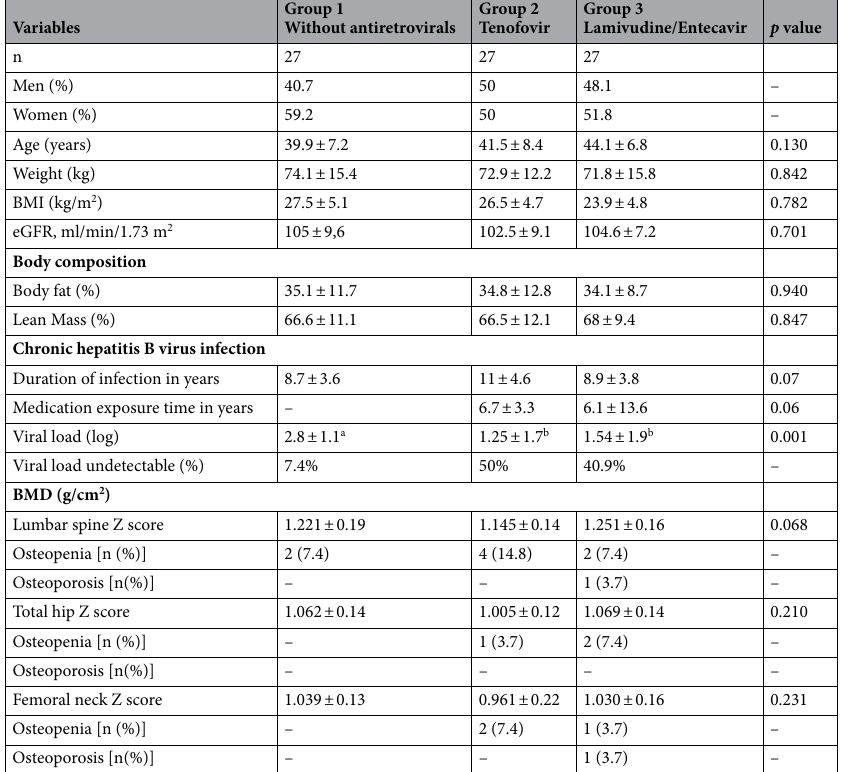
Table 1. General characteristics of patients with chronic hepatitis B virus infection in use or not of antiretrovirals. ANOVA one way and student t test for independent samples (medication exposure time in years). Values are expressed as mean ± standard deviation. Different letters p ≤ 0.05. eGFR: estimation of glomerular filtration rate; BMD: bone mineral density.